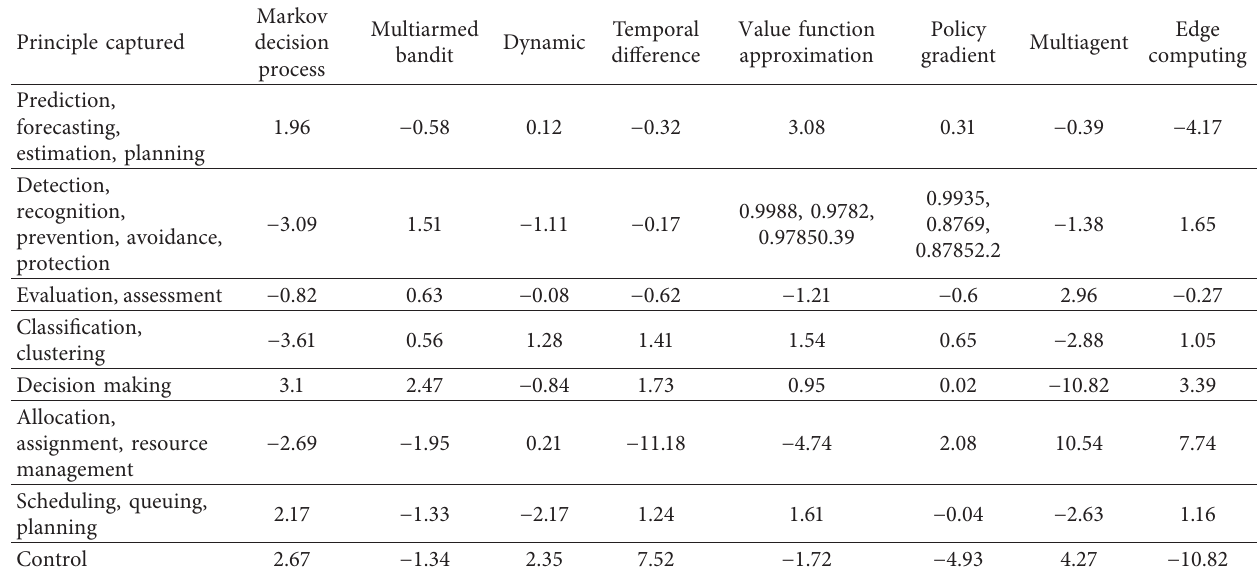
Table 2: χ 2 -test table of principle captured classes by RL method